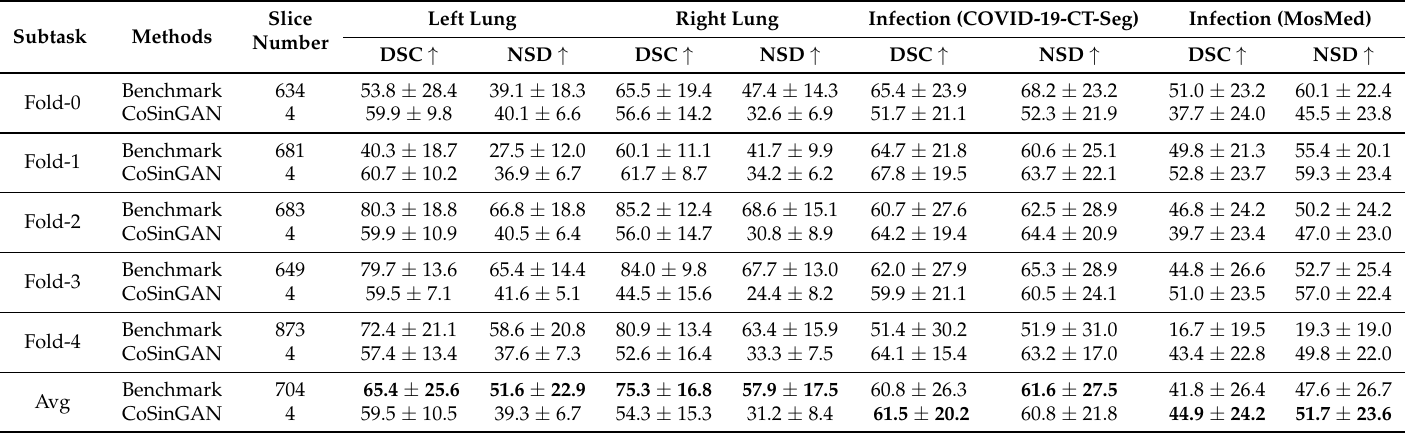
Table 6. Quantitative results (Mean±Standard deviation) of 5-fold cross validation and independent testing based on 3D U-Net. For each fold, average DSC and NSD values are reported. The last row shows the average results of 80 (=5 folds × 16 testing cases per fold) testing cases in the COVID-19-CT-Seg dataset and 250 (=5 folds × 50 testing cases per fold) testing cases in the MosMed dataset. The third column shows the number of real labeled CT slices used for training. ↑ denoting a higher score admits better segmentation performance. The entries in bold highlight the best average